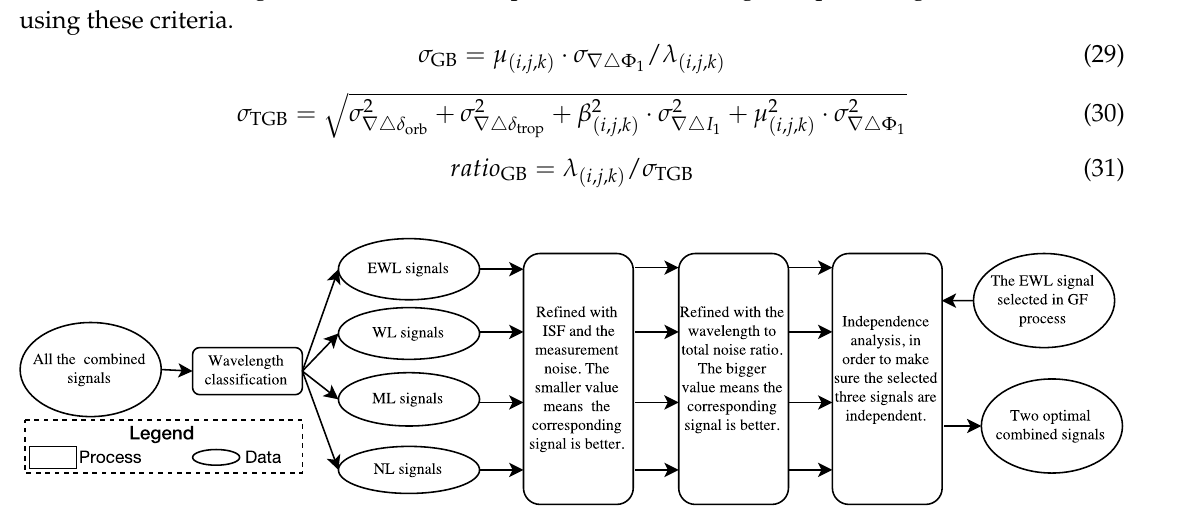
Figure 6. The procedure of selecting the optimal signals for GB TCAR.